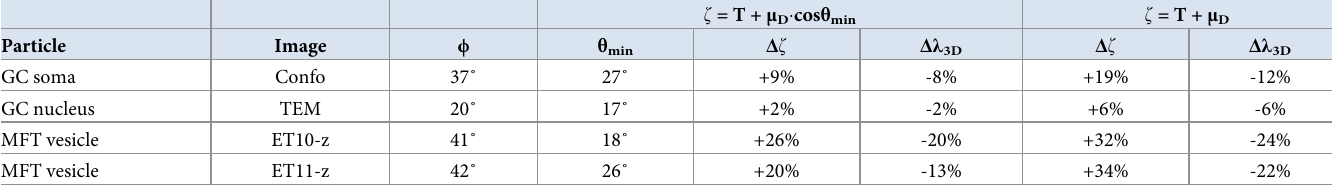
Table 5. Comparison of λ 3D estimated via the Keiding model, Abercrombie correction or Konigsmark (d min )